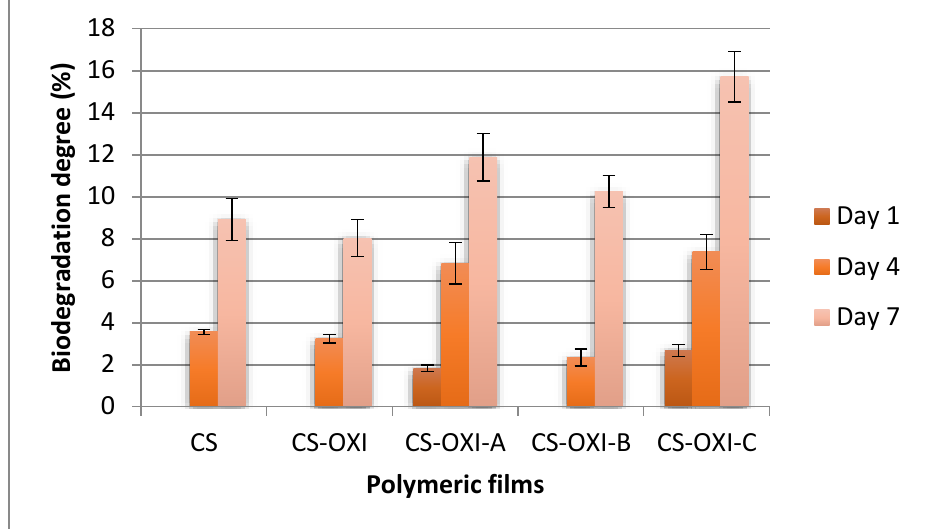
Figure 6. Biodegradation degree of polymeric films.